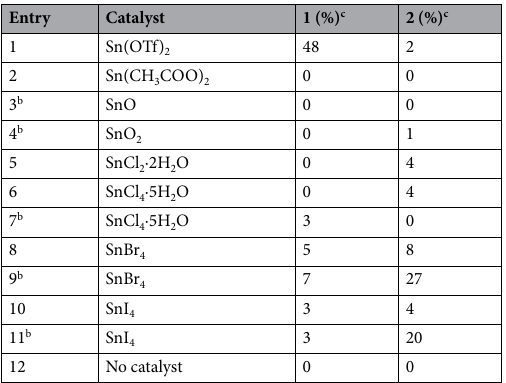
Table 1. Conversion of an authentic starch sample into methyl levulinate ( 1 ) and methyl lactate ( 2 ) using various catalysts a . a Reaction conditions: starch (50 mg), methanol (5.0 mL), catalyst (0.024 mmol), naphthalene (0.156 mmol), Ar (5 atm), 24 h, 160 °C. All reactions were performed twice, and the yields of 1 and 2 are average values. b Catalyst (0.24 mmol). c Yields (%) of each product are carbon-based. The amounts of 1 and 2 produced were determined by 1 H NMR